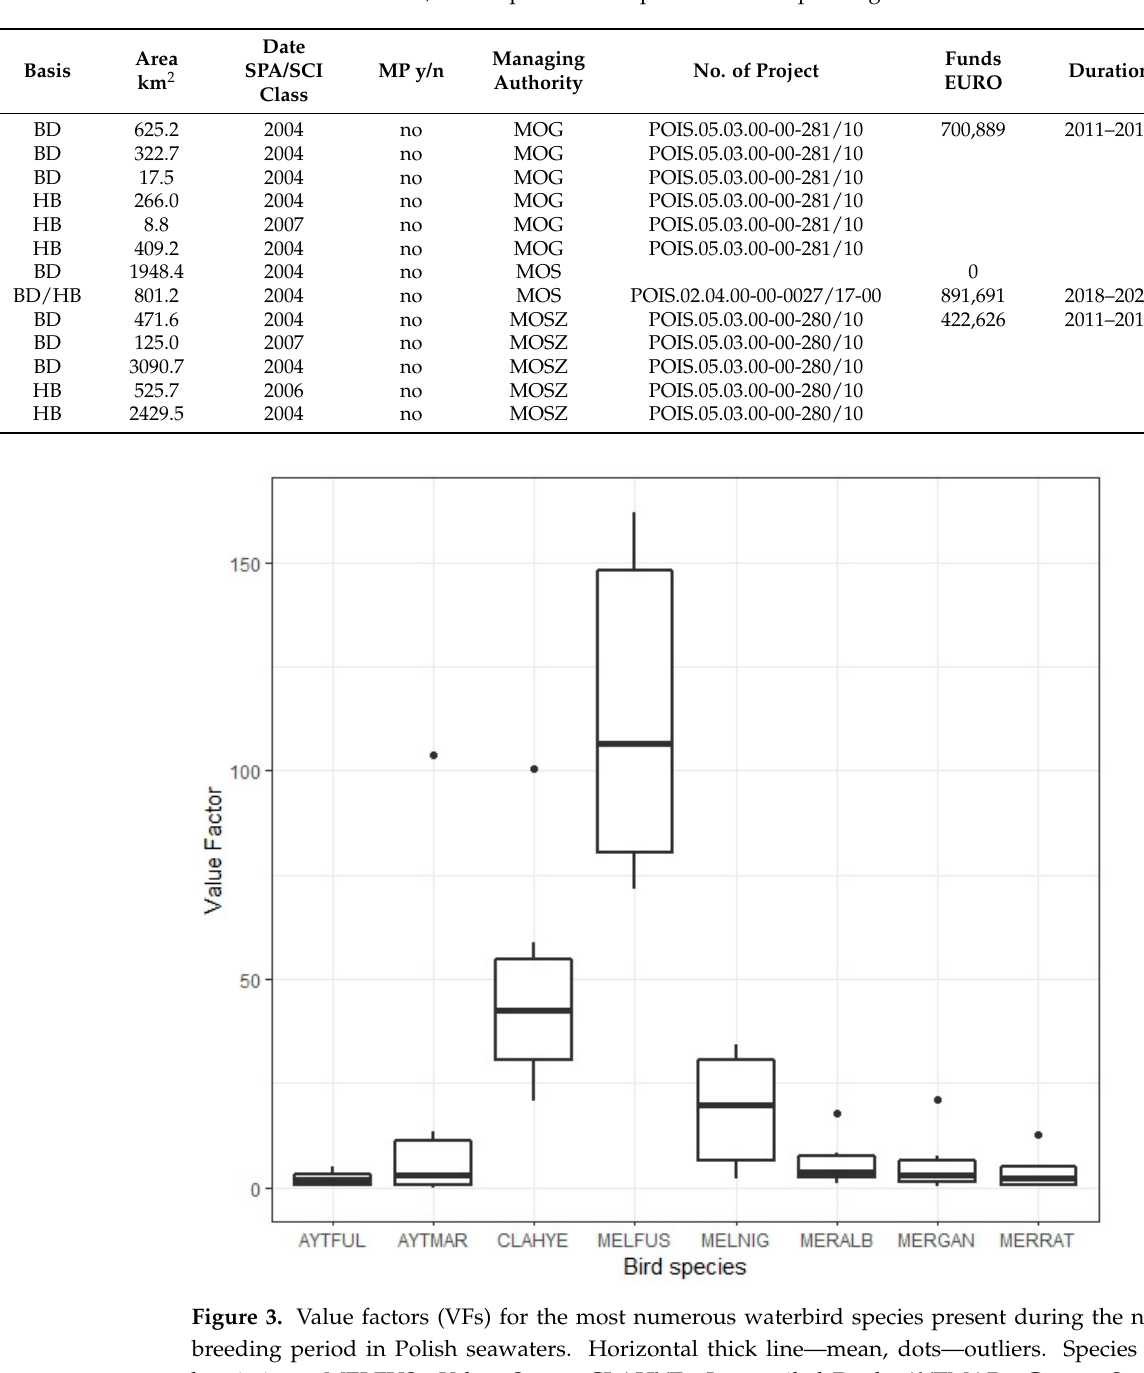
Table 2. List of Natura 2000 sites in Polish EEZ together with the area code and the legal basis on which the site was created (BD—Birds Directive, HD—Habitats Directive). MOG—Maritime